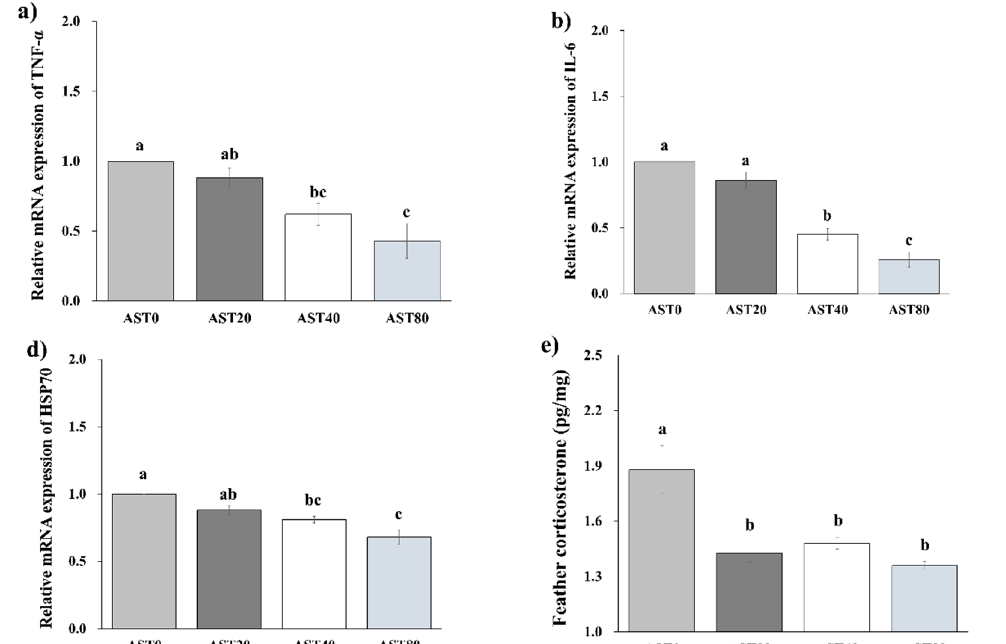
Figure 3. Relative mRNA expression of TNF α ( a ), IL-6 ( b ), HSP27 ( c ), and HSP70 ( d ) in the liver, and feather corticosterone concentration of broiler under high temperature ( e ). AST0, basal diet; AST20, basal diet + 20 ppm astaxanthin; AST40, basal diet + 40 ppm astaxanthin; AST80, basal diet + 80 ppm astaxanthin; TNF, Tumor necrosis factor; IL, Interleukin; HSP, Heat shock protein. Bars with different letters (a–c) differ significantly across all treatments ( p < 0.05).